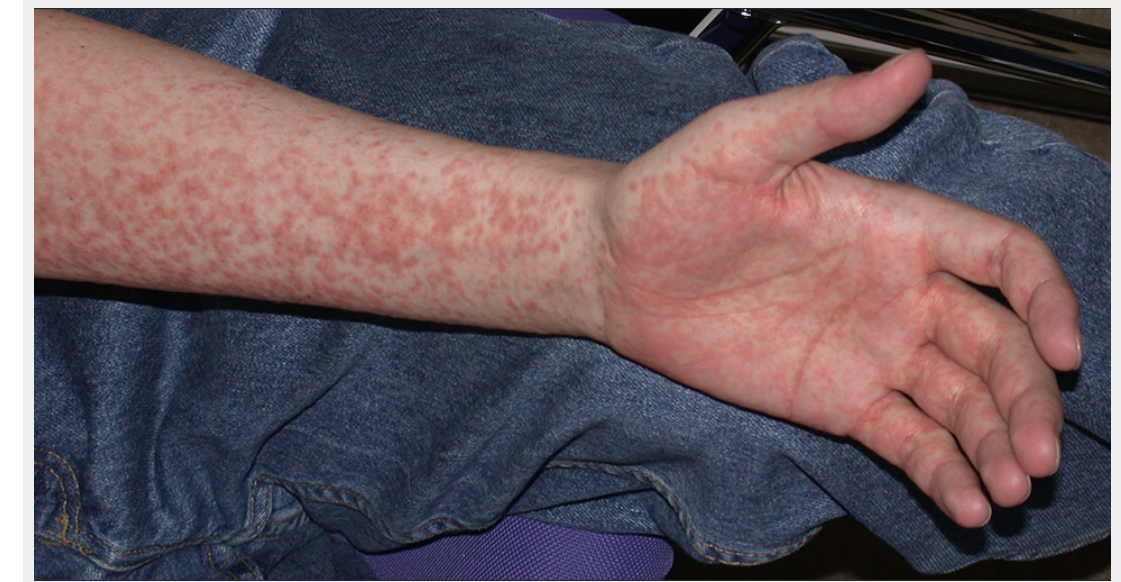
Figure 4A Morbilliform exanthema of acute GvHD of the skin including the palma